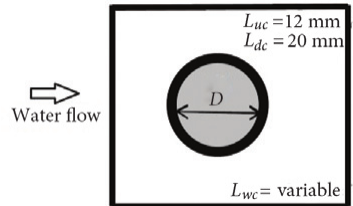
Fig. 8. Two-sided collar with varying width